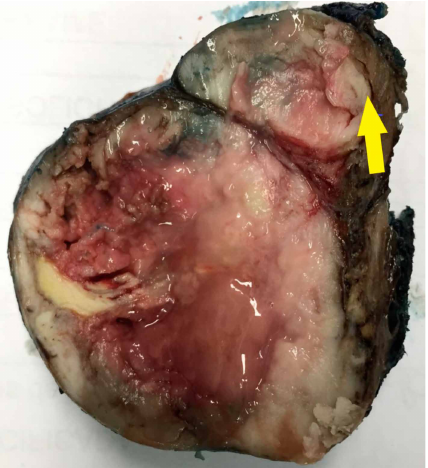
Figure 3: Nuclear magnetic resonance (NMR) revealed a suspected nodule localized in left lobe of thyroid, measuring approximately 4.0 cm in diameter. Besides this, the thyroid increased in size and, clinically, the lesion may extend from the left for the right side.